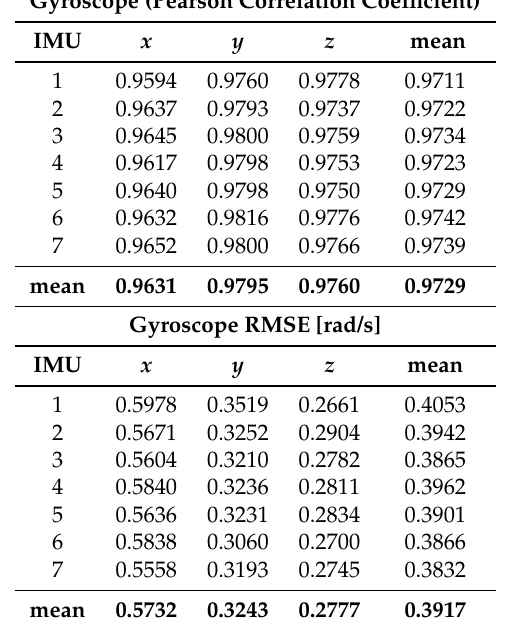
Table A3. Pearson correlation coefficients and root mean squared errors (RMSE) between real and re-simulated gyroscope data from a capturing setup where the seven IMUs used in the experiments were rigidly mounted on a rigid body and were additionally tracked with a marker based optical system.